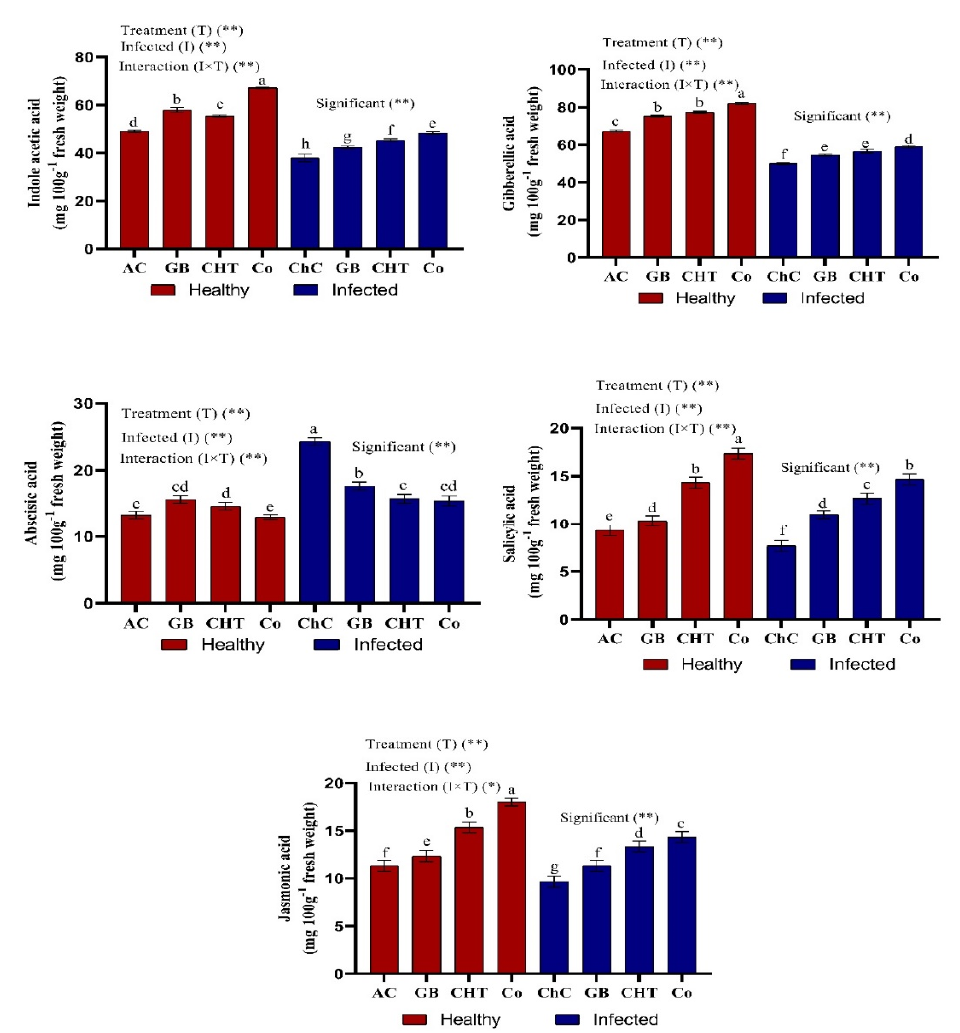
Figure 4. Effect of foliar spray by glycine betaine (GB), chitosan (CHT) and combination (Co) on phytohormones content in leaves of cucumber plant under absolute control (AC) and CMV infection (challenge control, ChC) after 21 days of inoculation. Means with the different letters (a, b, c, d, e, f, g) are significantly different at the 0.05 level among treatments according to Tukey’s test. Vertical bars represent means of three independent determinations ± standard error (SE). * and ** indicate significant and highly significant difference according to two-way ANOVA with Tukey’s post hoc test.